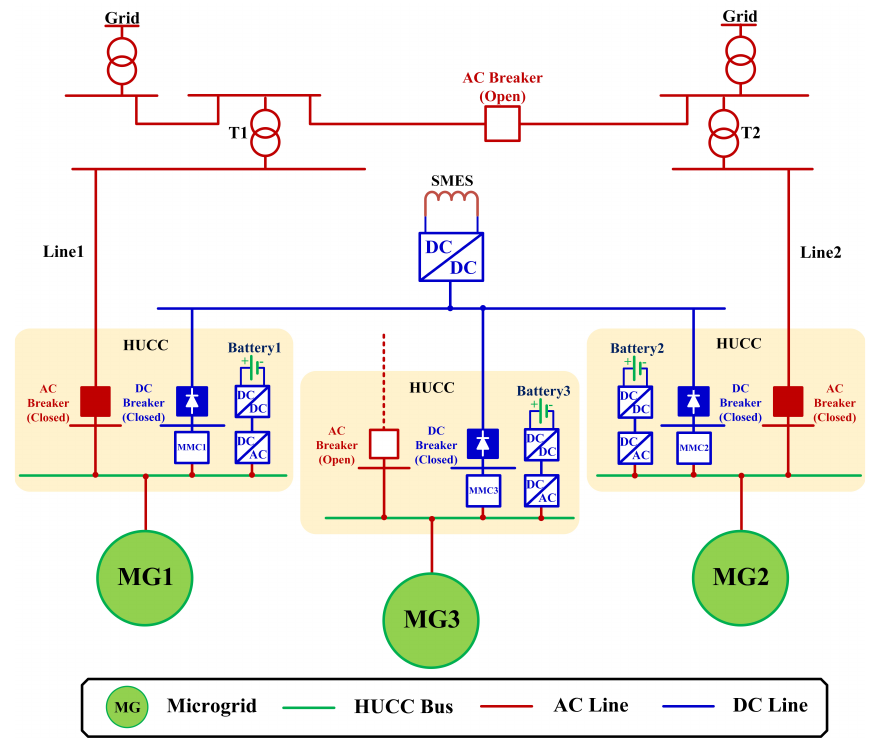
Figure 1. Multiple microgrids (MMGs) configuration.